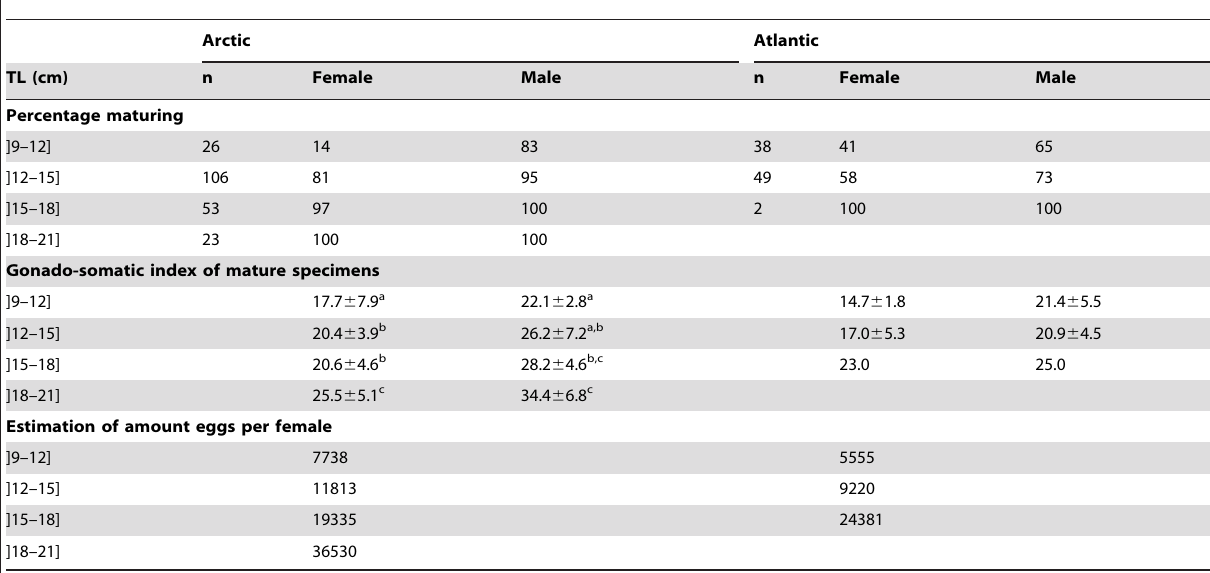
Table 2. Description of the maturing fraction of polar